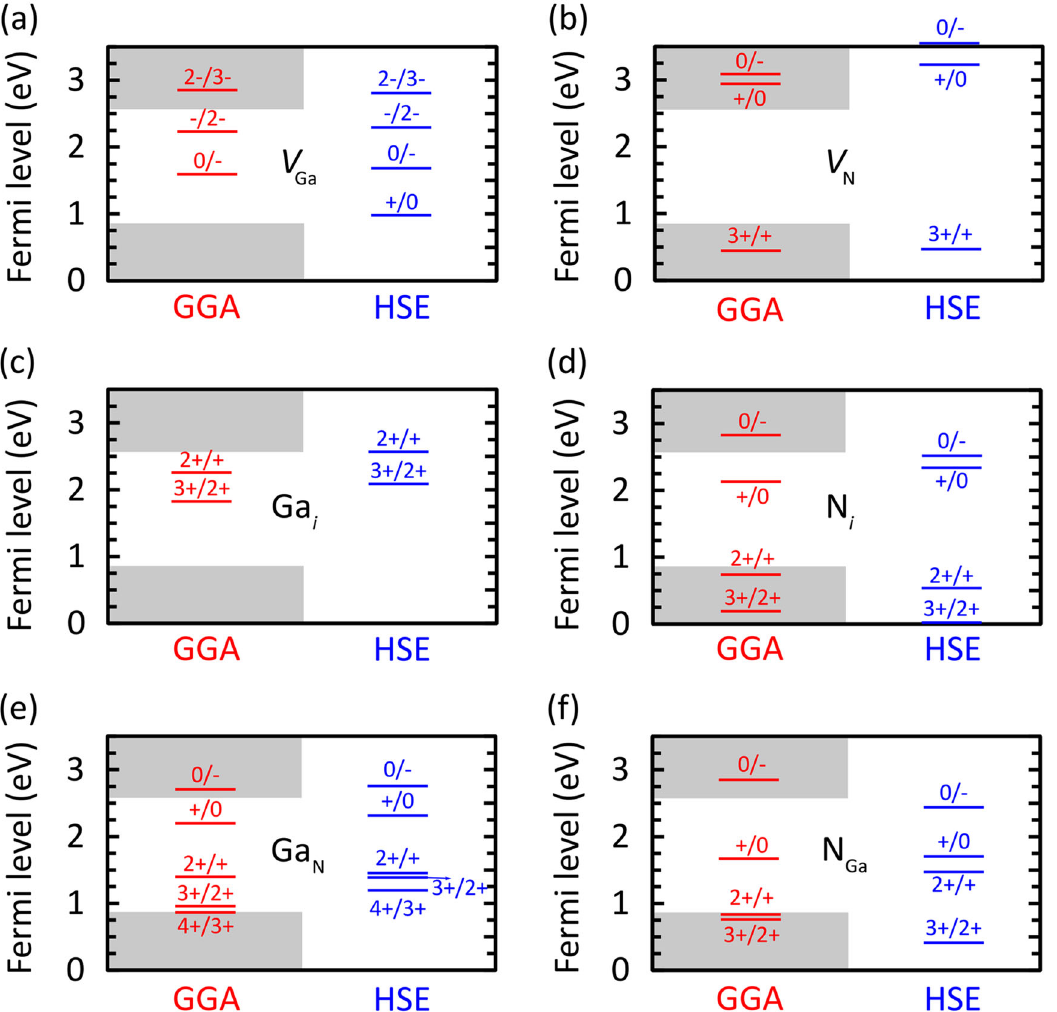
Fig. 4 Comparison of thermodynamic transition levels for a the gallium vacancy ( V Ga ), b nitrogen vacancy ( V N ), c gallium self-interstitial (Ga i ), d nitrogen self-interstitial